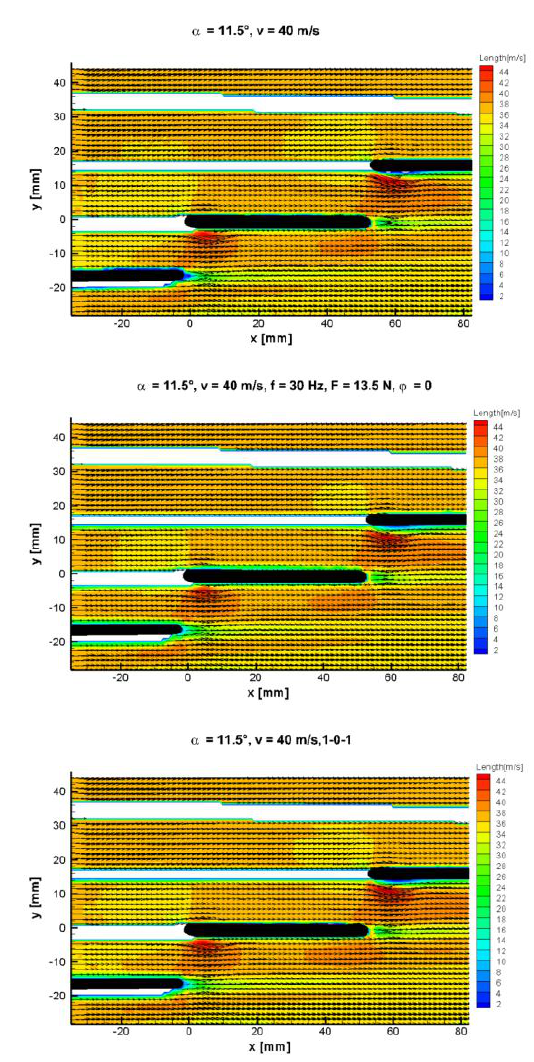
Fig. 3a, b, c. Comparison of mean flow field